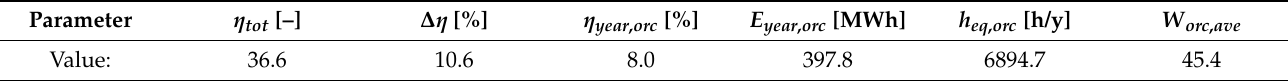
Figure 9. Comparison between the net power output of the mGT reference configuration and mGT + ORC configuration. Data are related to a whole year of operation. Violet shaded areas come from the overlap of the two histograms. Table 4. Modified layout performance. Reference case fuel efficiency equal to